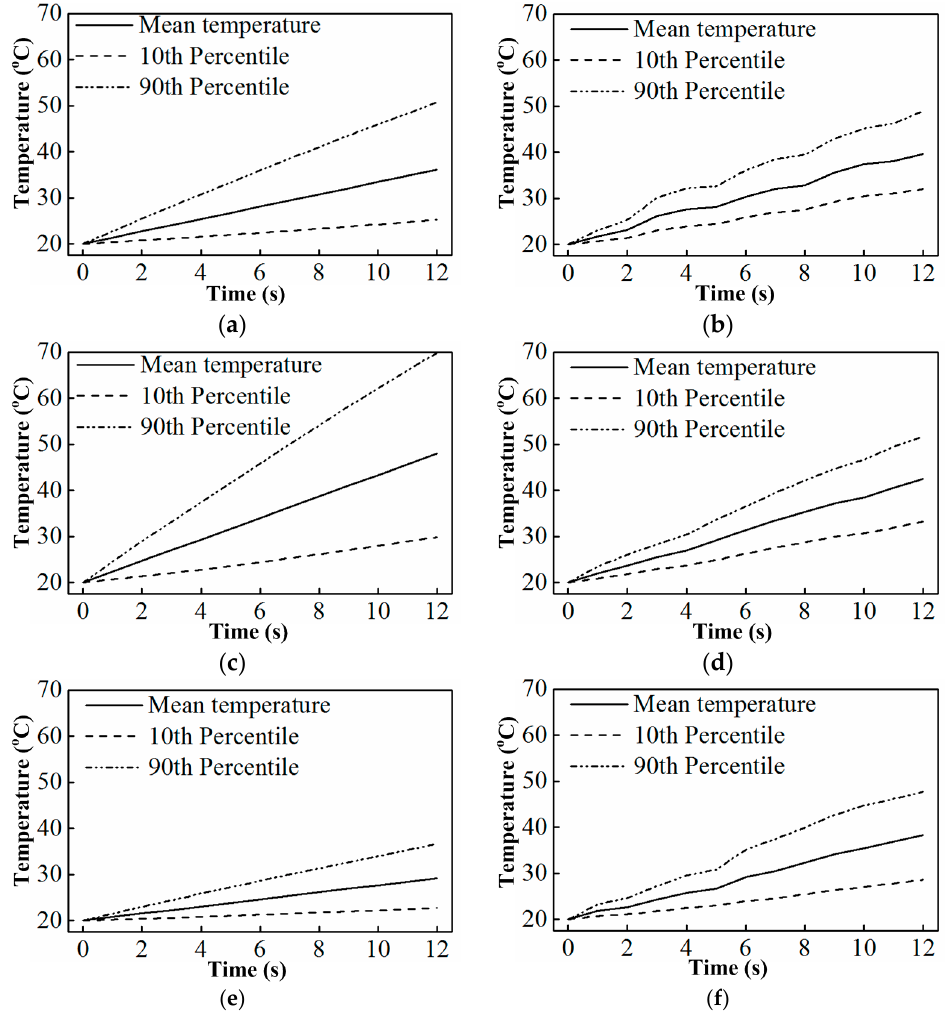
Figure 10. Potato temperature range as a function of heating time with a multi-material turntable or a single material turntable: ( a ) PE turntable; ( b ) PE-alumina turntable; ( c ) aluminum turntable; ( d ) PE-aluminum turntable; ( e ) alumina turntable; and ( f ) alumina-aluminum turntable.